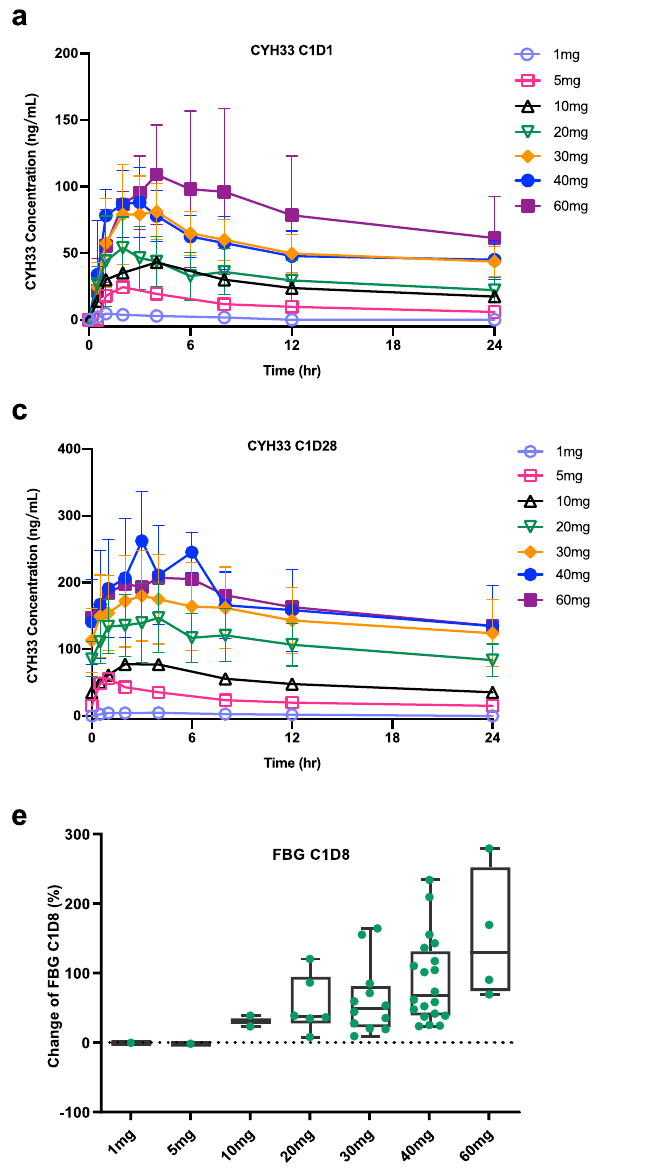
Fig. 2 | Pharmacokinetic results. a CYH33 and b its active metabolite I27 Concentration-Time Pro fi les (Mean±SD) on Cycle 1 Day 1 (1mg, n =1; 5mg, n =1; 10mg, n =2; 20mg, n =5; 30mg, n =12; 40mg, n =3; 60mg, n =4); c CYH33 and d its active metabolite I27 Concentration-Time Pro fi les (Mean±SD) on Cycle 1 Day 28 (1mg, n =1; 5mg, n =1; 10mg, n =2; 20mg, n =6; 30mg, n =9; 40mg, n =7; 60mg, n =2); e Pharmacodynamic results showing changes of FBG levels from